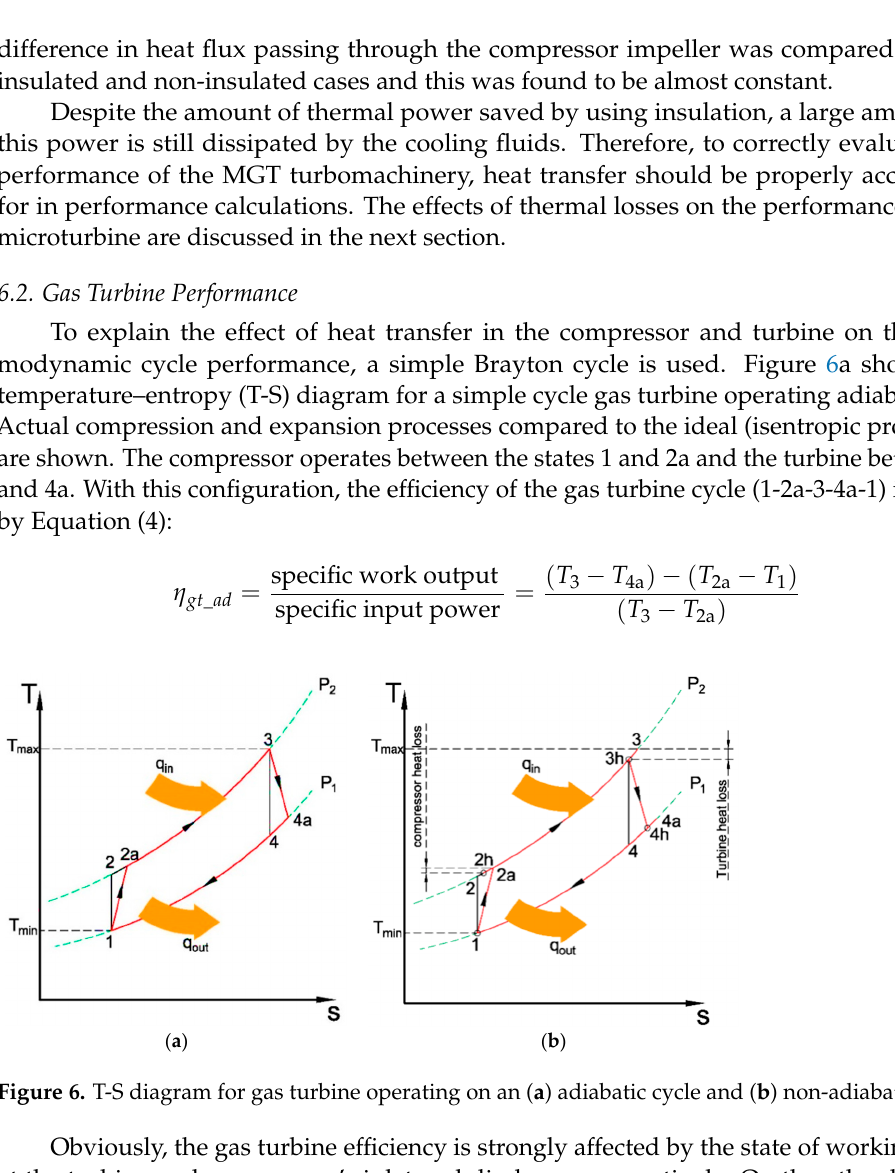
Table 7. Heat loss in the turbine and